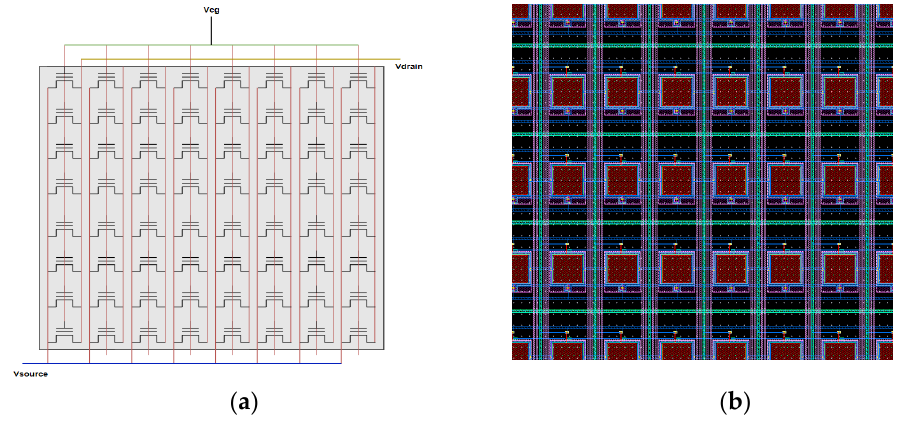
Figure 4. Mosaic connectivity: ( a ) schematics; ( b ) Layout.